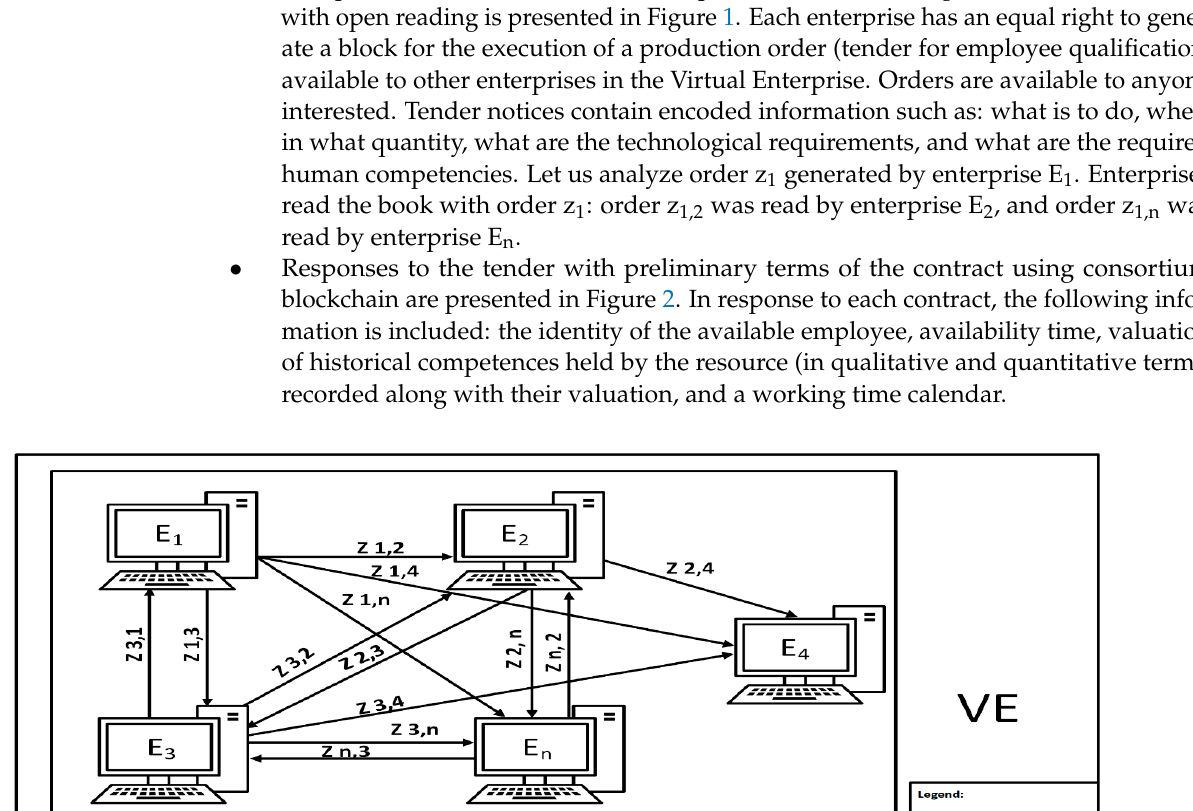
Figure 3. Generating orders to companies in the VE according to the highest competence rule using consortium blockchain. A BC network is often referred to a distributed network (Figure 4). Such a network consists mainly of nodes, i.e., individual systems (of computer centers of enterprises) that store and care for the validity of transactions, and users, i.e., entities or people who have the ability to read the book.